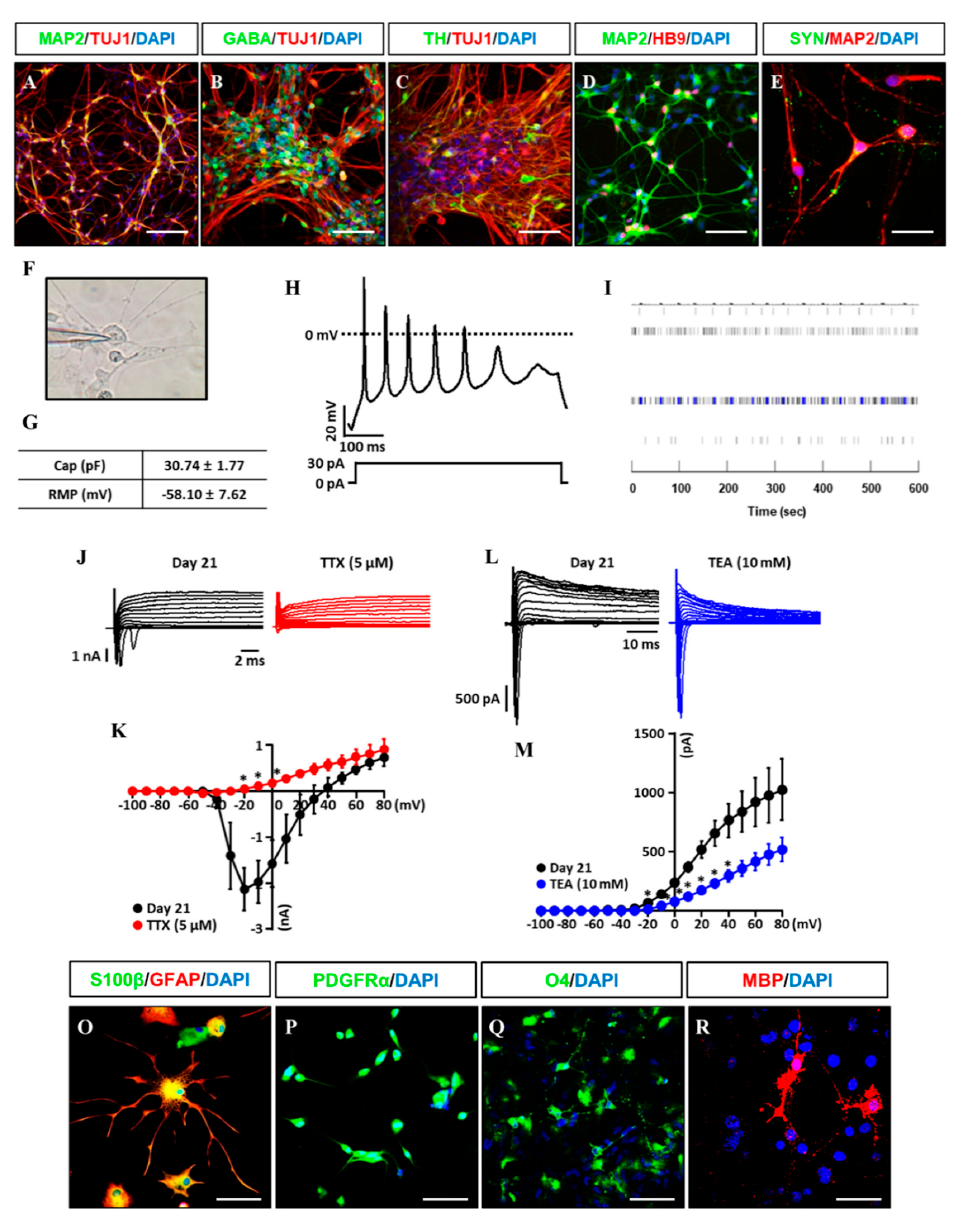
Figure 5. Differentiation potential of iNSCs in vitro. ( A – E ) Neuronal markers (TUJ1, MAP2, GABA, TH, HB9, and SYN) expression in iNSC-derived neurons, as determined by immunofluorescence analysis. ( F ) Image of patch clamp experiments. ( G ) Capacitance and resting membrane potential (RMP) were 30.74 pF ± 1.77 and − 58.10 mV ± 7.62 in iNSC-derived neurons, respectively. ( H ) Representative trace of current clamp recordings of iNSC-derived neurons. Voltage responses were recorded from a holding potential of − 80 mV using 500 ms steps with 30 pA of current injection. ( I ) MEA system showed spontaneous electronic spikes induced by iNSC-derived neurons. ( J , K ) The peak inward-currents due to Na + channels were inhibited by addition of 5 µ M Tetrodotoxin (TTX) (red, n = 3). ( L , M ) The outward-currents due to K + channels were inhibited by addition of 10 mM TEA (blue, n = 4). For voltage-clamp recordings, sodium and potassium currents were recorded from a holding potential of − 80 mV using 500 ms pulse voltage steps from − 100 to + 80 in 10 mV increments. Values are mean ± SEM. * p < 0.05 vs. absence of TTX or TEA. ( O ) Astroglial markers (GFAP and S100 β ) expression in iNSC-derived astroglia, as determined by immunofluorescence analysis. ( P – R ) Oligodendroglial markers (PDGFR α , O4, and MBP) expression in iNSC-derived oligodendroglia, as determined by immunofluorescence analysis. Scale bars, 200 µ